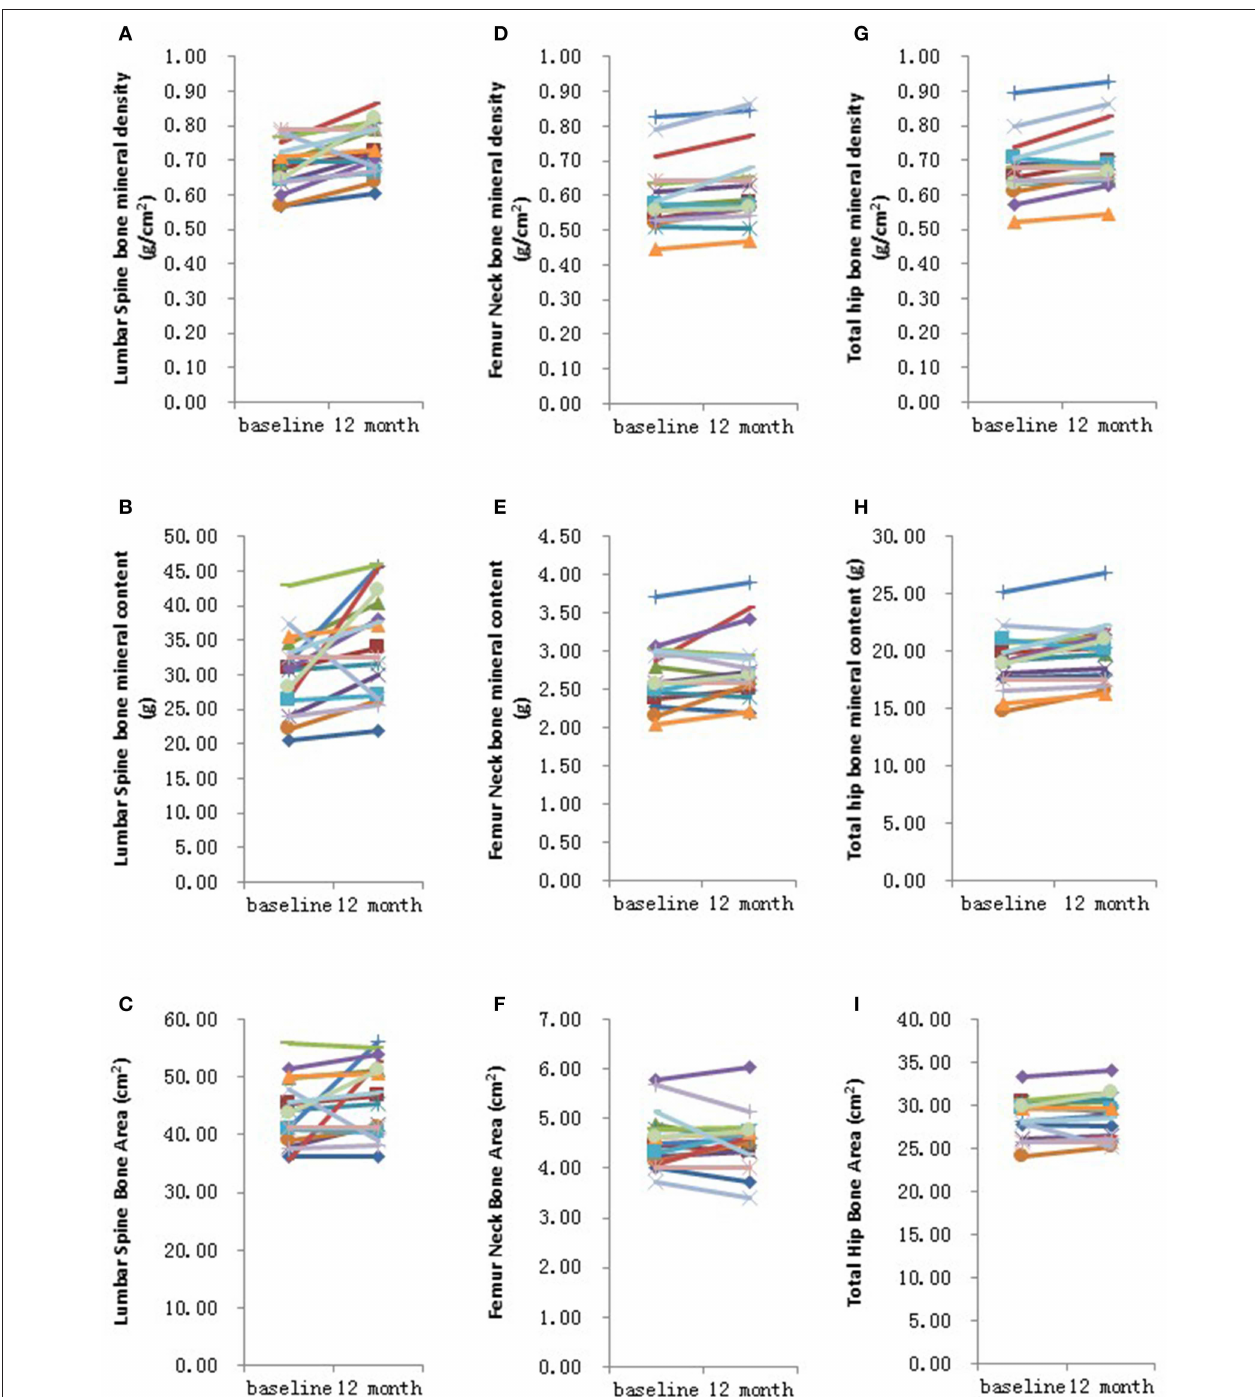
FIGURE 2 | Graphical representation in changes in individual site measurements before and after 12 months HRT. (A) Lumbar spine bone mineral density; (B) Lumbar spine bone mineral content; (C) Lumbar spine bone area; (D) Femur neck bone mineral density; (E) Femur neck bone mineral content; (F) Femur neck bone area; (G) Total hip bone mineral density; (H) Total hip bone mineral content; (I) Total hip bone area. N = 17. indicated that for whole body BMD, femur neck BMD and The current study demonstrates that HRT was an effective total hip BMD, chronic estrogen deficiency may be the major way to increase whole body BMD, femur neck BMD, total hip reason for bone loss in these sites, but for lumbar spine BMD, BMD, but not lumbar spine BMD in Chinese TS girls, which